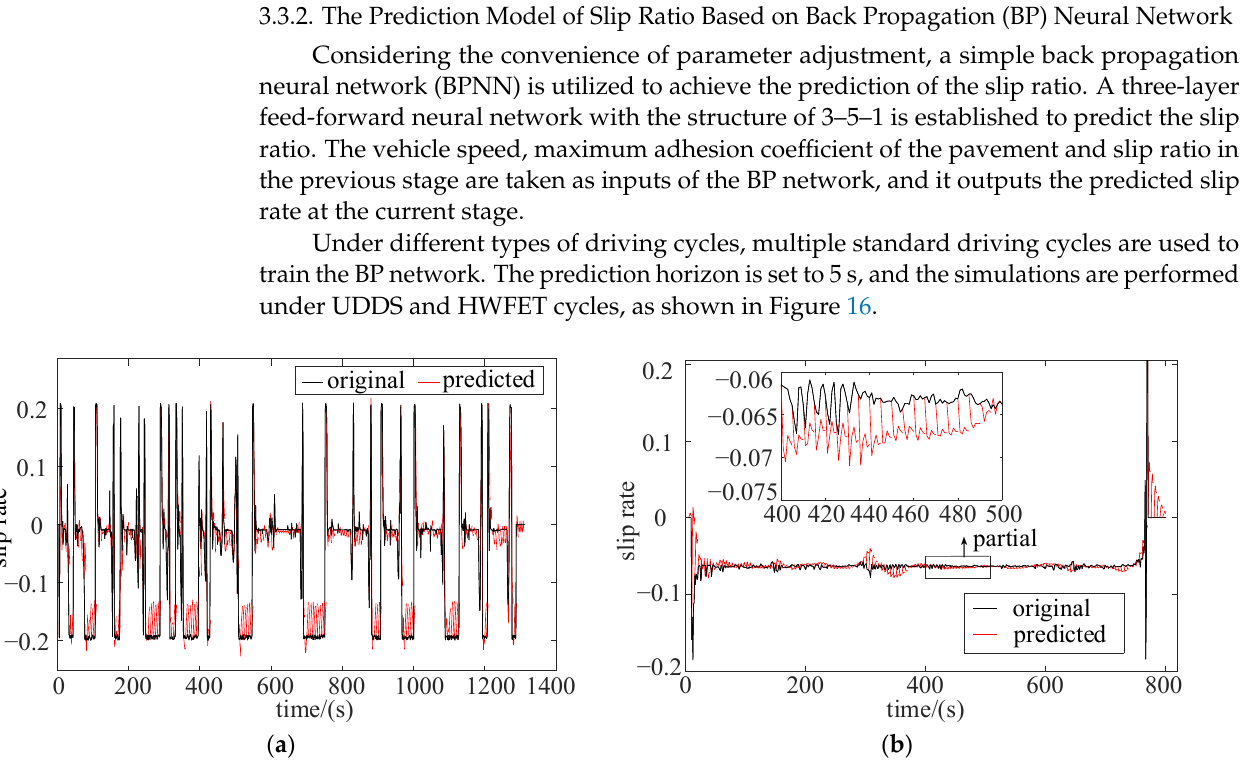
... Figure 17. Schematic diagram of state feasible domain at each prediction horizon.